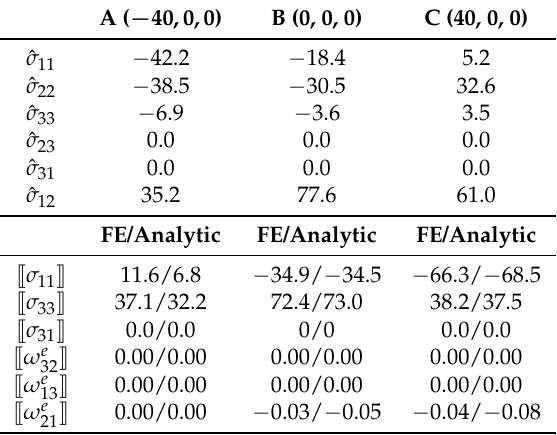
Table 1. Values of ˆ σ (MPa) provided by the FE simulation 1 and used to compute the analytic ∼ formulas (28)–(30) and (32) (top). Comparisons of the values of [[ σ simulation 1 and those computed from the analytic formulas